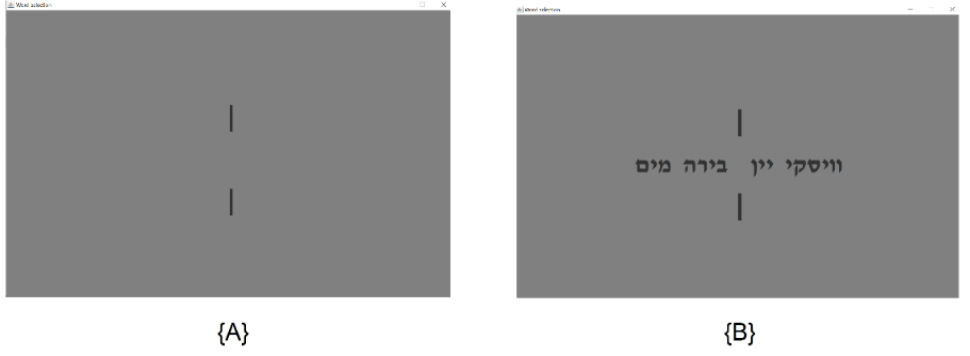
Figure 1. ( A ) Stand by screen. ( B ) Game board #1 [“Water”, “Beer”, “Wine”, “Whisky”].